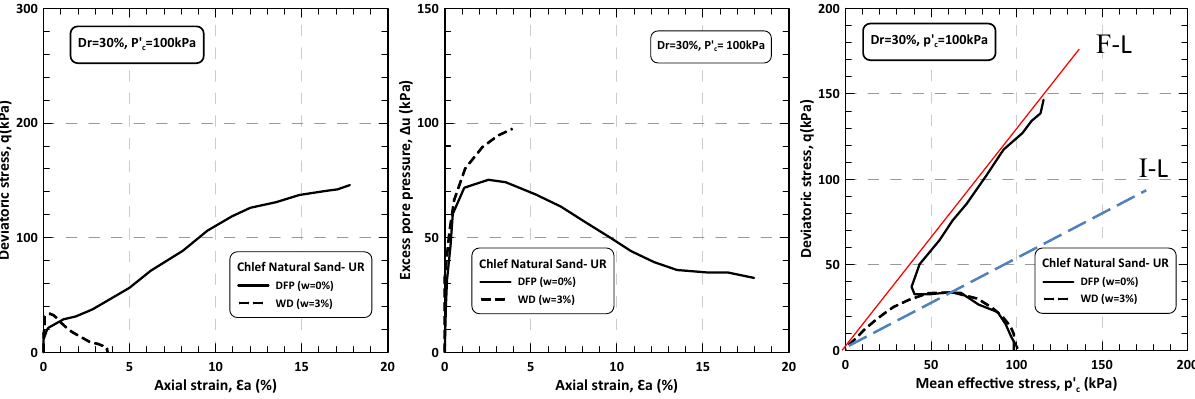
Fig. 6 Effect of deposition method on the undrained response of unreinforced sand samples at p ′ stress versus axial strain, b excess pore pressure against axial strain, c effective stress